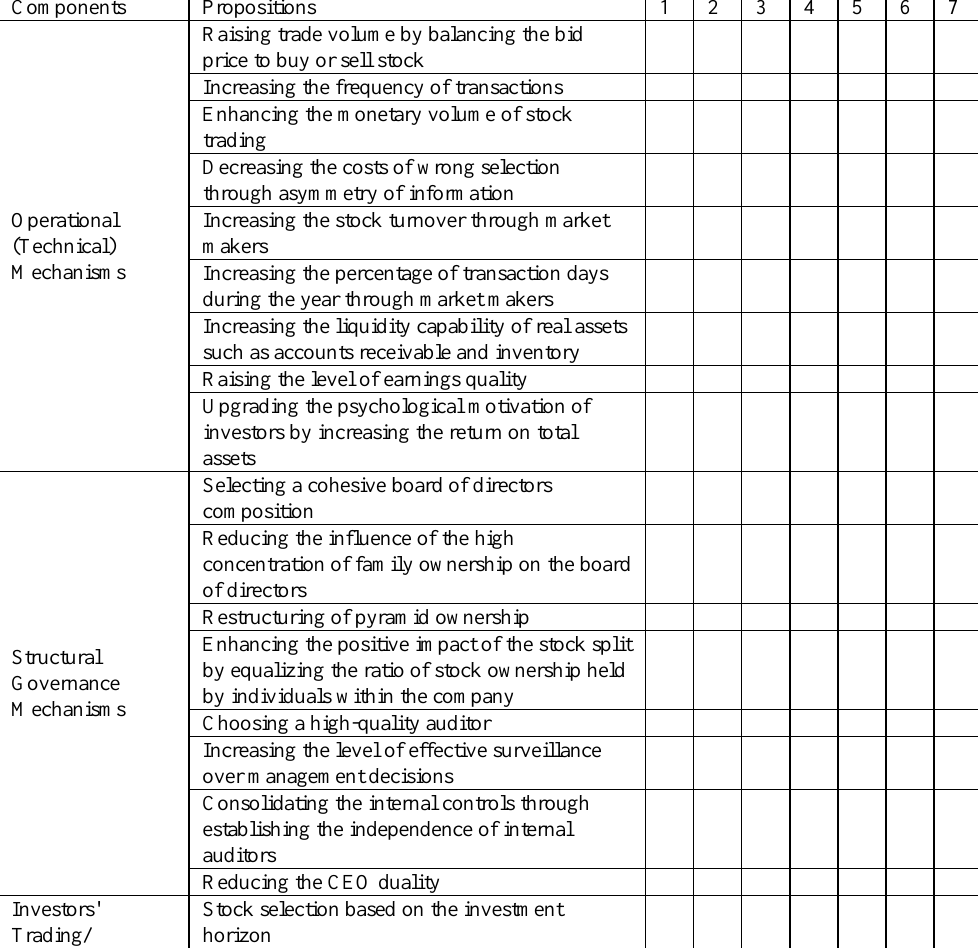
Table 4. Determining the research propositions in the form of a 7-item scale checklist